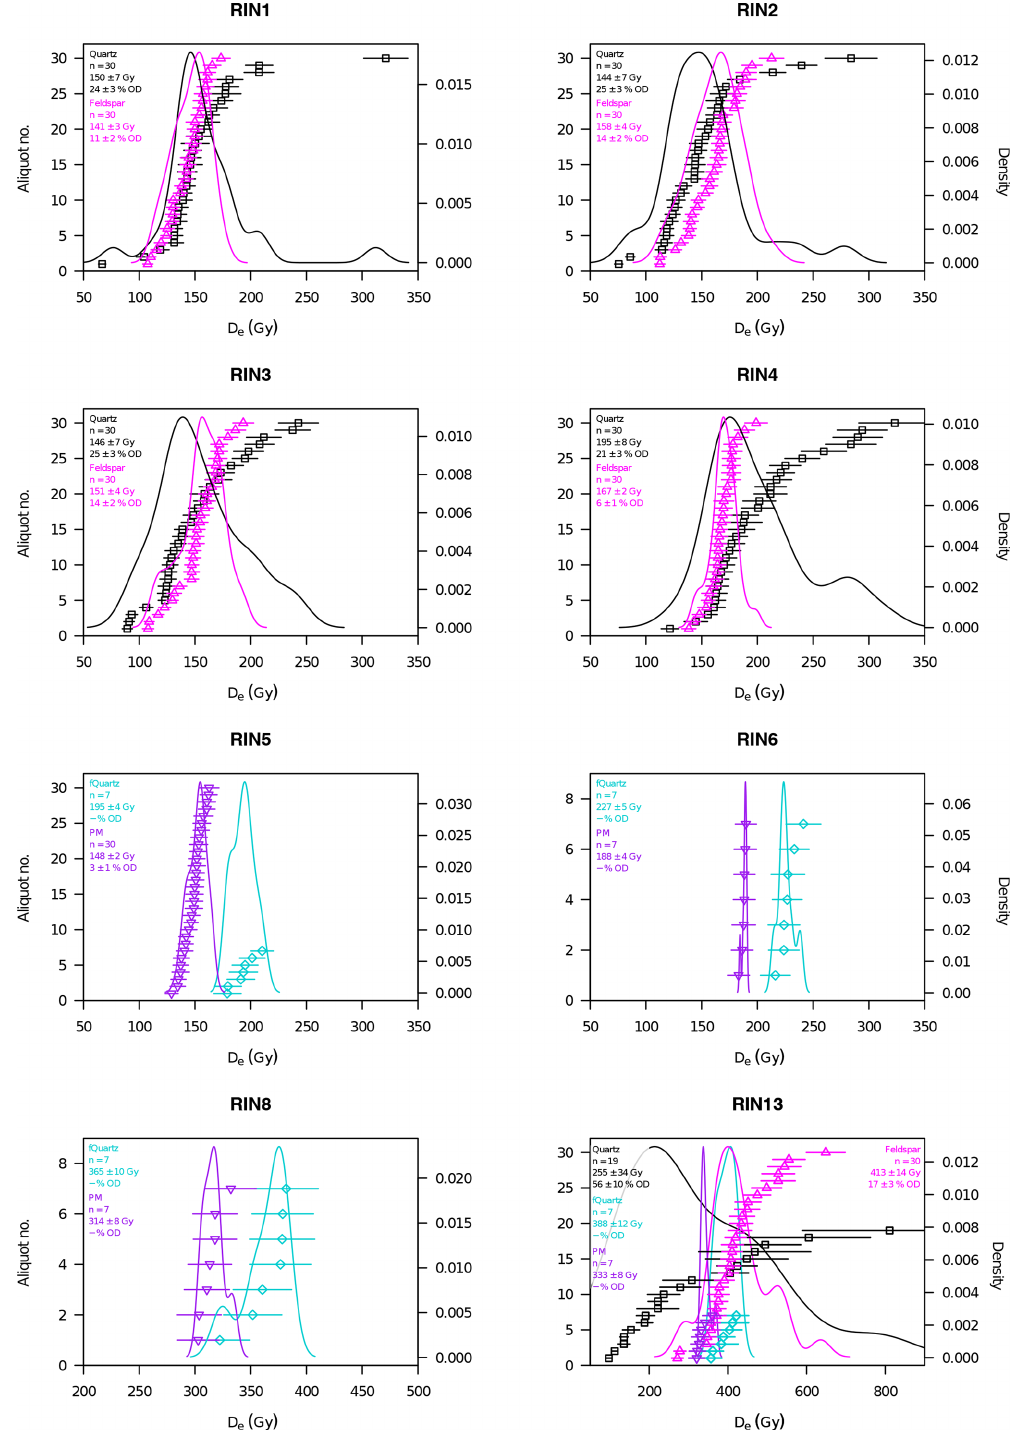
Figure 12. D e distributions of all measured samples and minerals. CAM D e values are given with 1 σ uncertainty. F and PM D e values are